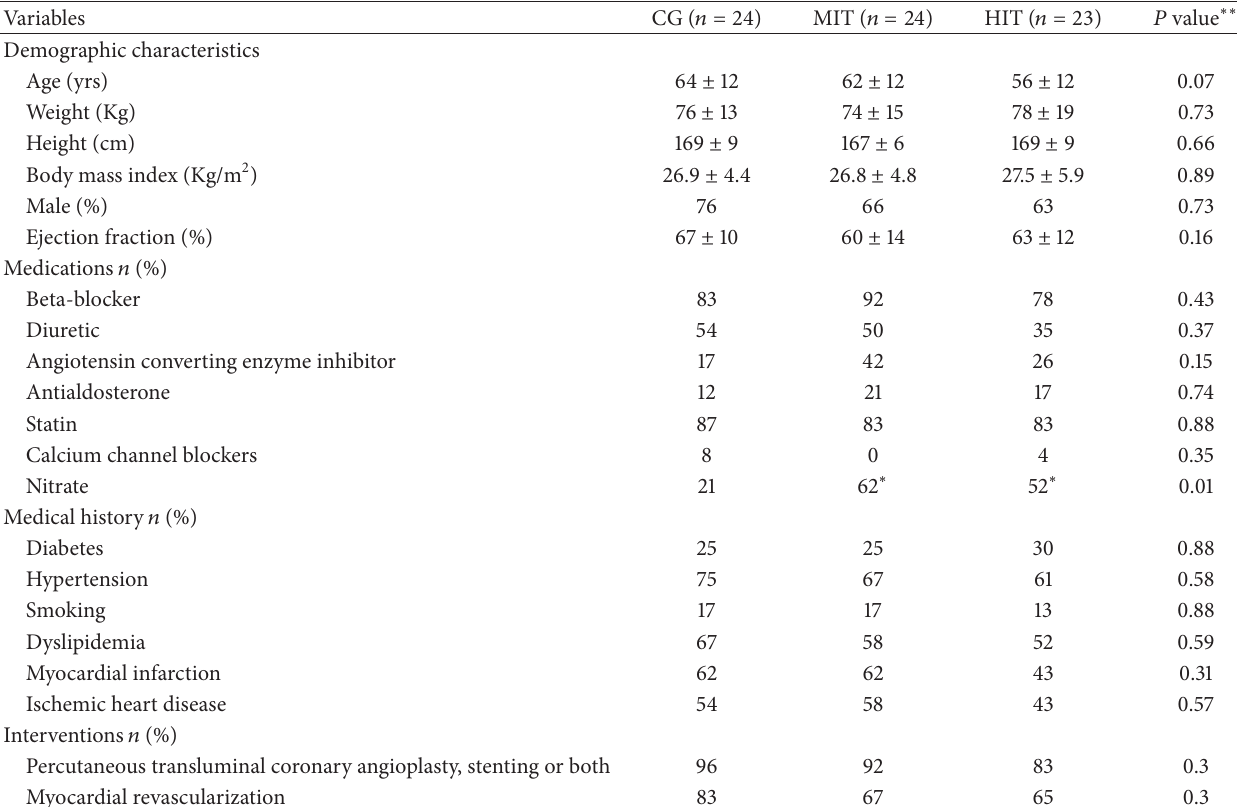
Table 1: Demographic and clinical characteristics among